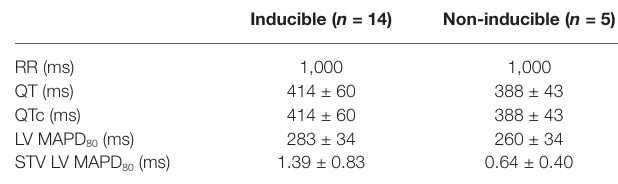
TABLE 2 | Baseline electrophysiological parameters of inducible and non- inducible